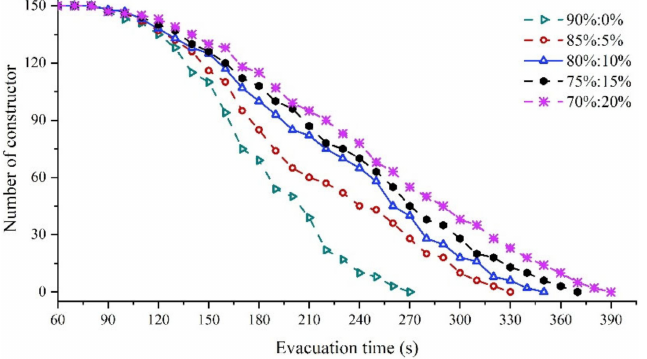
Figure 10. Evacuation process of constructors with different age composition ratios.